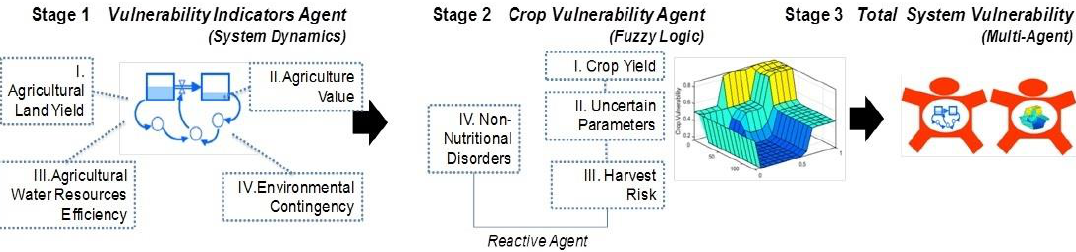
Figure 1. Methodology for determining total system vulnerability based on intelligent agents.